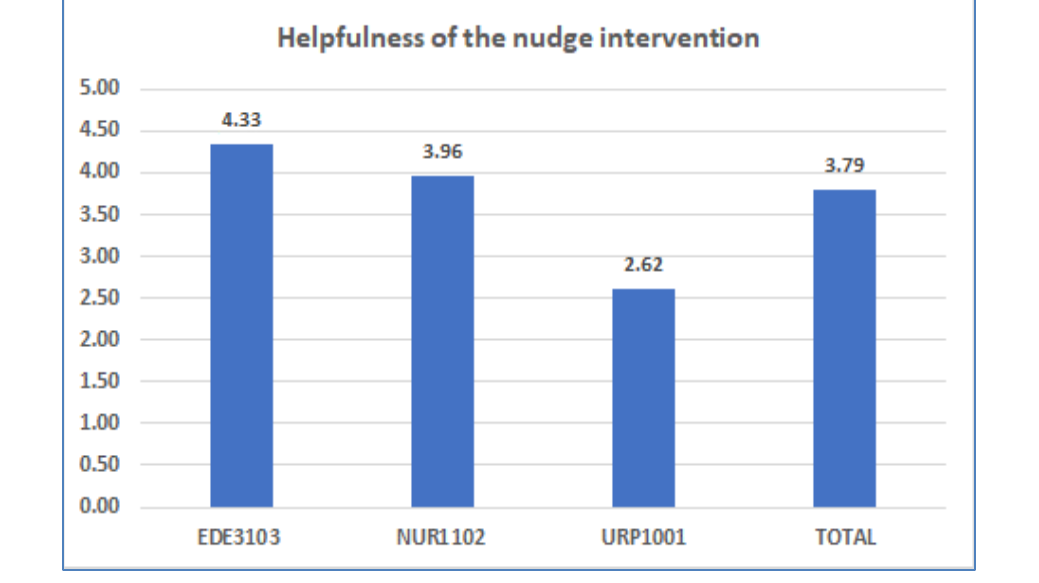
Figure 2 . Nudges perceived as moderately to very helpful in EDE3103 and NUR1102 (4.3 to